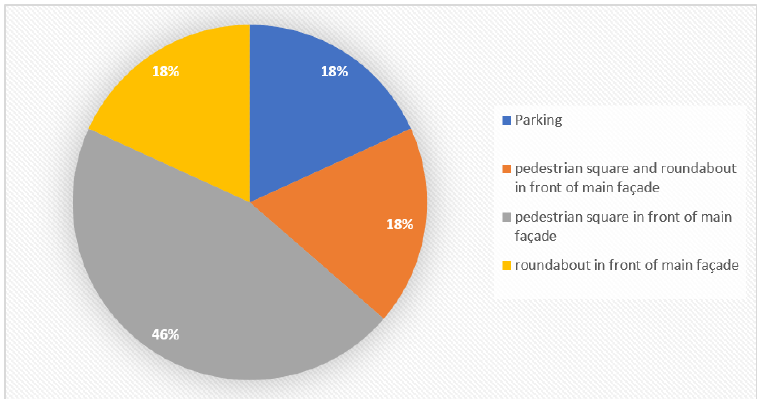
Figure 6. Urban action on railway tracks. Own elaboration.